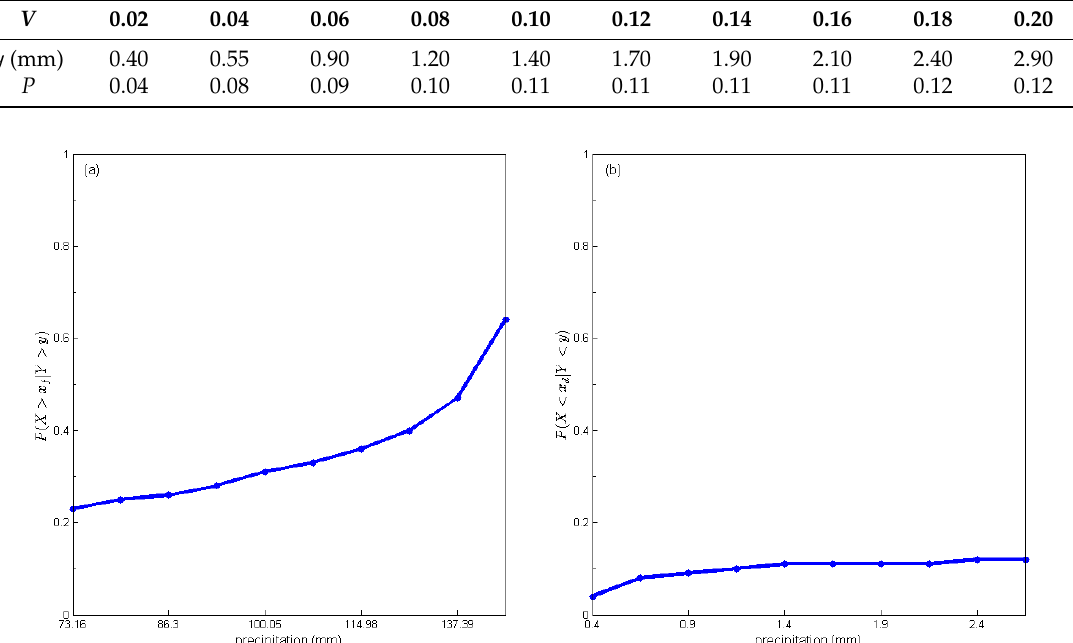
Table 5. The conditional probability that P ( X < x d | Y < y ) at y = 0.40, 0.55, 0.90, 1.20, . . . , 2.90 mm.